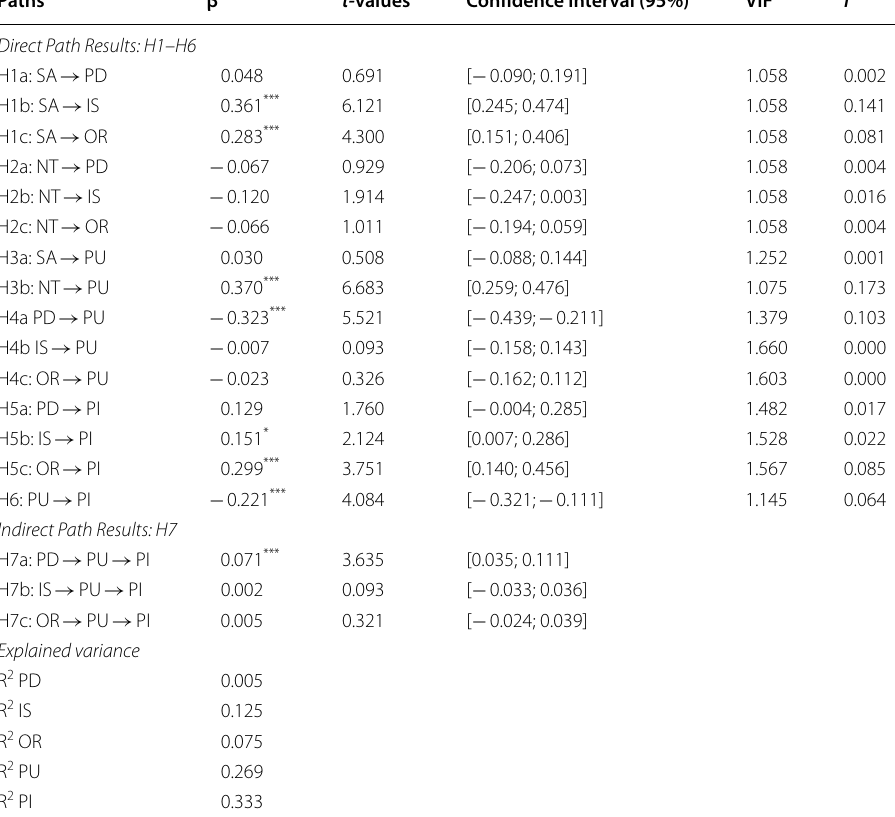
Table 3 Structural